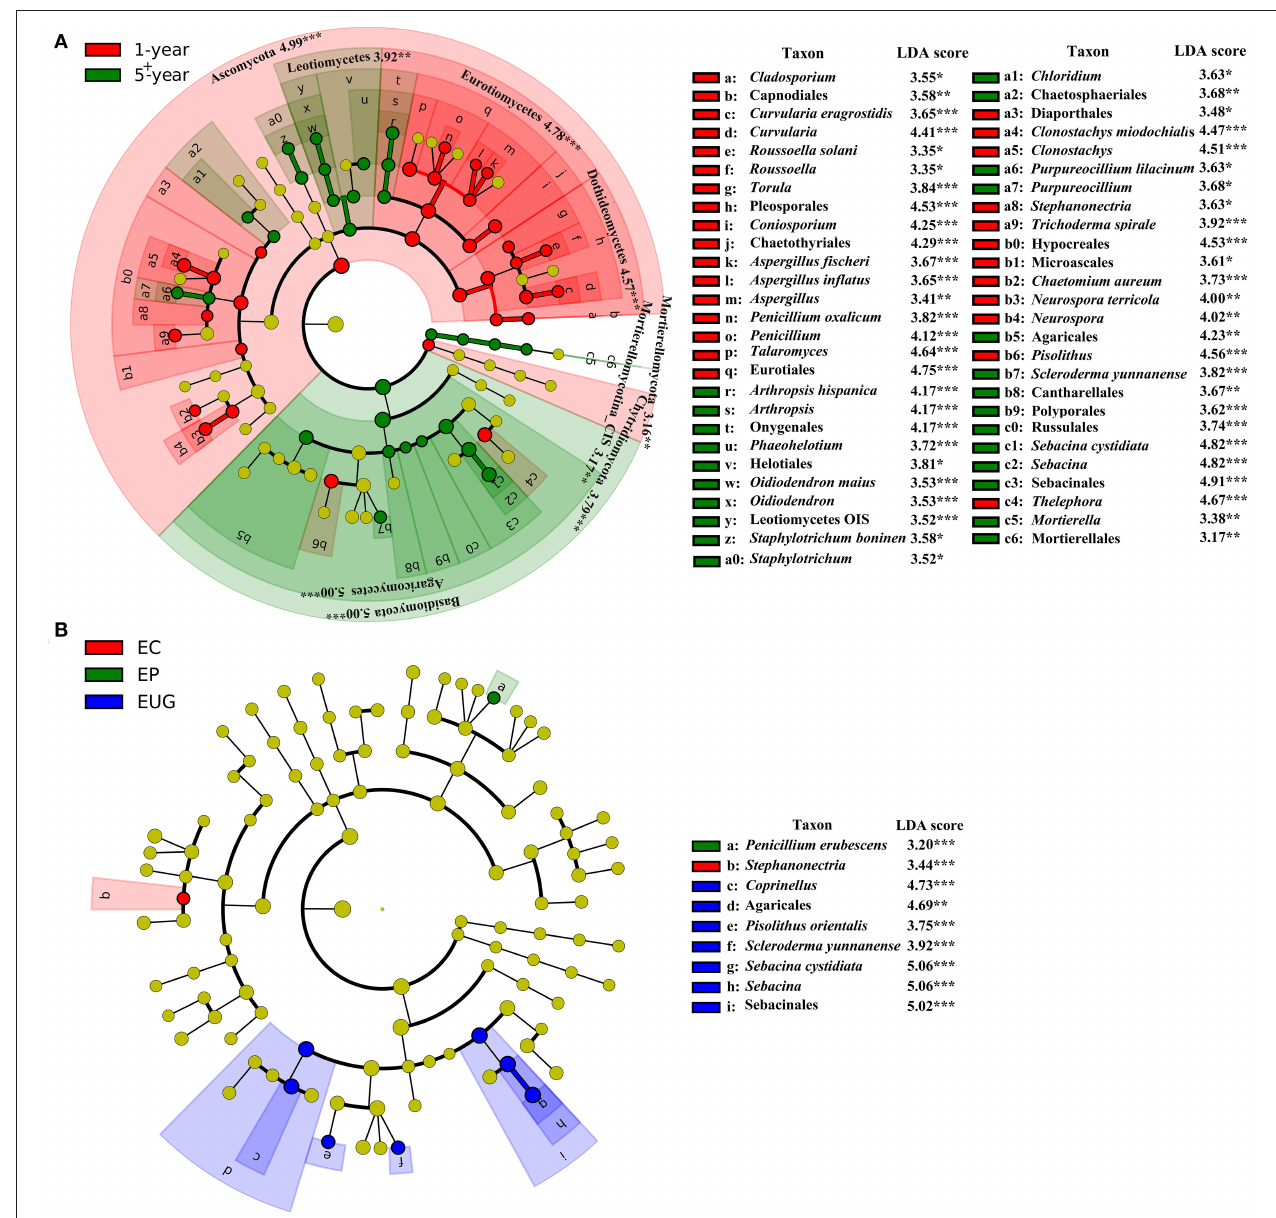
FIGURE 3 | Fungal taxa (without family) significantly differentiated in Eucalyptus plantations with (A) different ages and (B) different species, identified by linear discriminant analysis coupled with effect size (LEfSe) using parameters of a threshold of linear discriminant analysis (LDA) score > 3 and p < 0.05. From the inner circle to the outer circle of tree diagrams are fungal taxa of phylum, class, order, genus, and species. The red and green nodes and shades shown in (A) represent fungal taxa that play an important role in the 1- and 5 + -year-old plantations, respectively; the red, green, and blue nodes and shades shown in (B) represent fungal taxa that play an important role in EC, EP, and EUG plantations, respectively; the yellow nodes represent fungal taxa that do not play an important role in each treatment. EC, E. camaldulensis ; EP, E. pellita ; EUG, E. urophylla × E. grandis ; CIS, Class Incertae sedis ; OIS, Order Incertae sedis . *signifiant level of 5%; **significant level of 1%, and ***significant level of